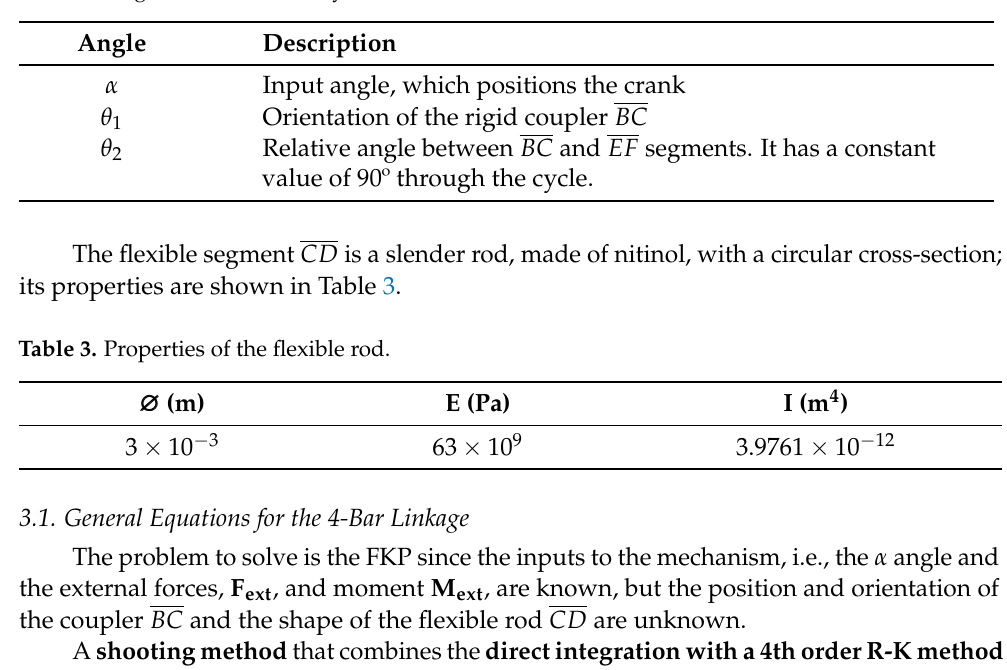
Table 2. Angles data of the analyzed mechanism.